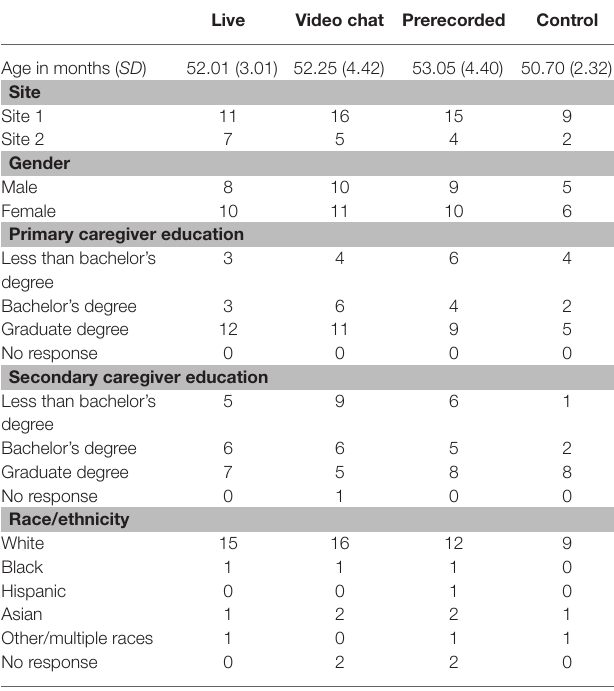
Experimental N = 58 for transfer vocabulary measure, 57 for receptive vocabulary measure, 56 for explicit comprehension measure, 54 for expressive vocabulary, 53 for page-by-page retell, and 52 for implicit comprehension; Control N =